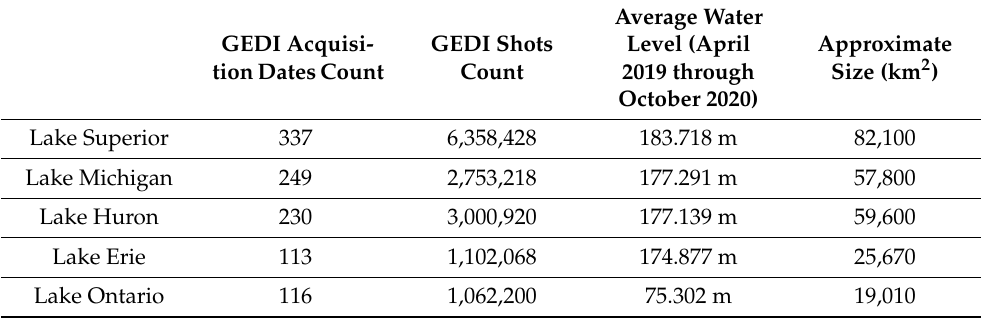
Table 1. Global Ecosystem Dynamics Investigation (GEDI) acquisition dates between April 2019 and October 2020 and available GEDI shots count over the studied